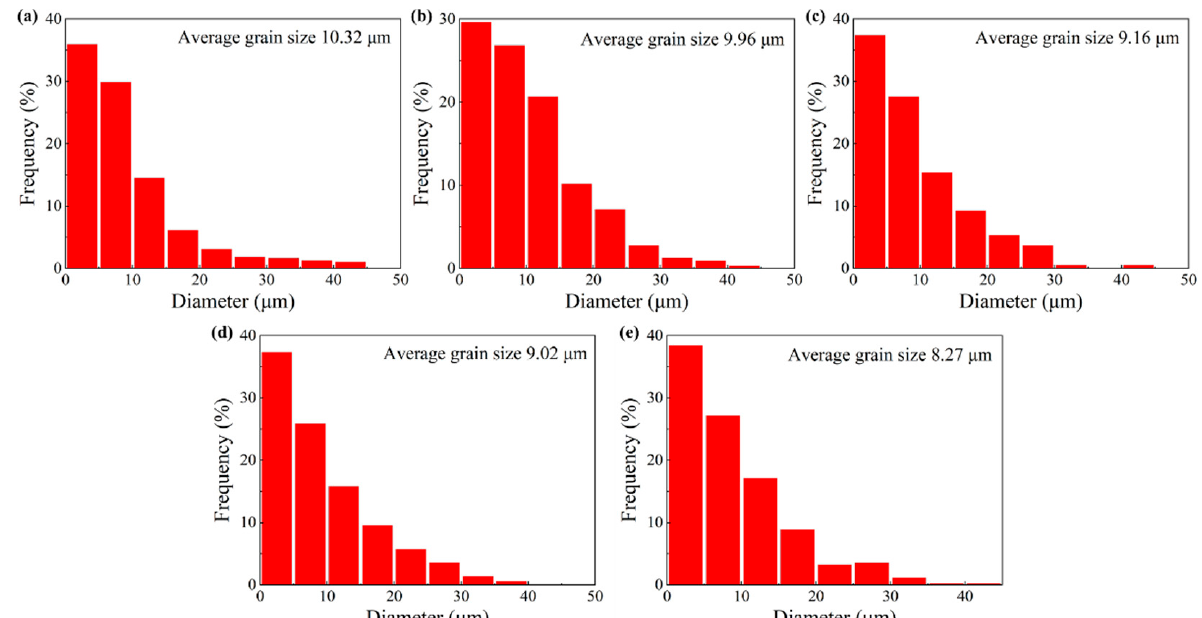
Figure 9. Grain size distributions after two-stage deformation with different prior cold strains and the same thermal deformation condition. ( a ) 0; ( b ) 0.163; ( c ) 0.223; ( d ) 0.288; ( e ) 0.357.